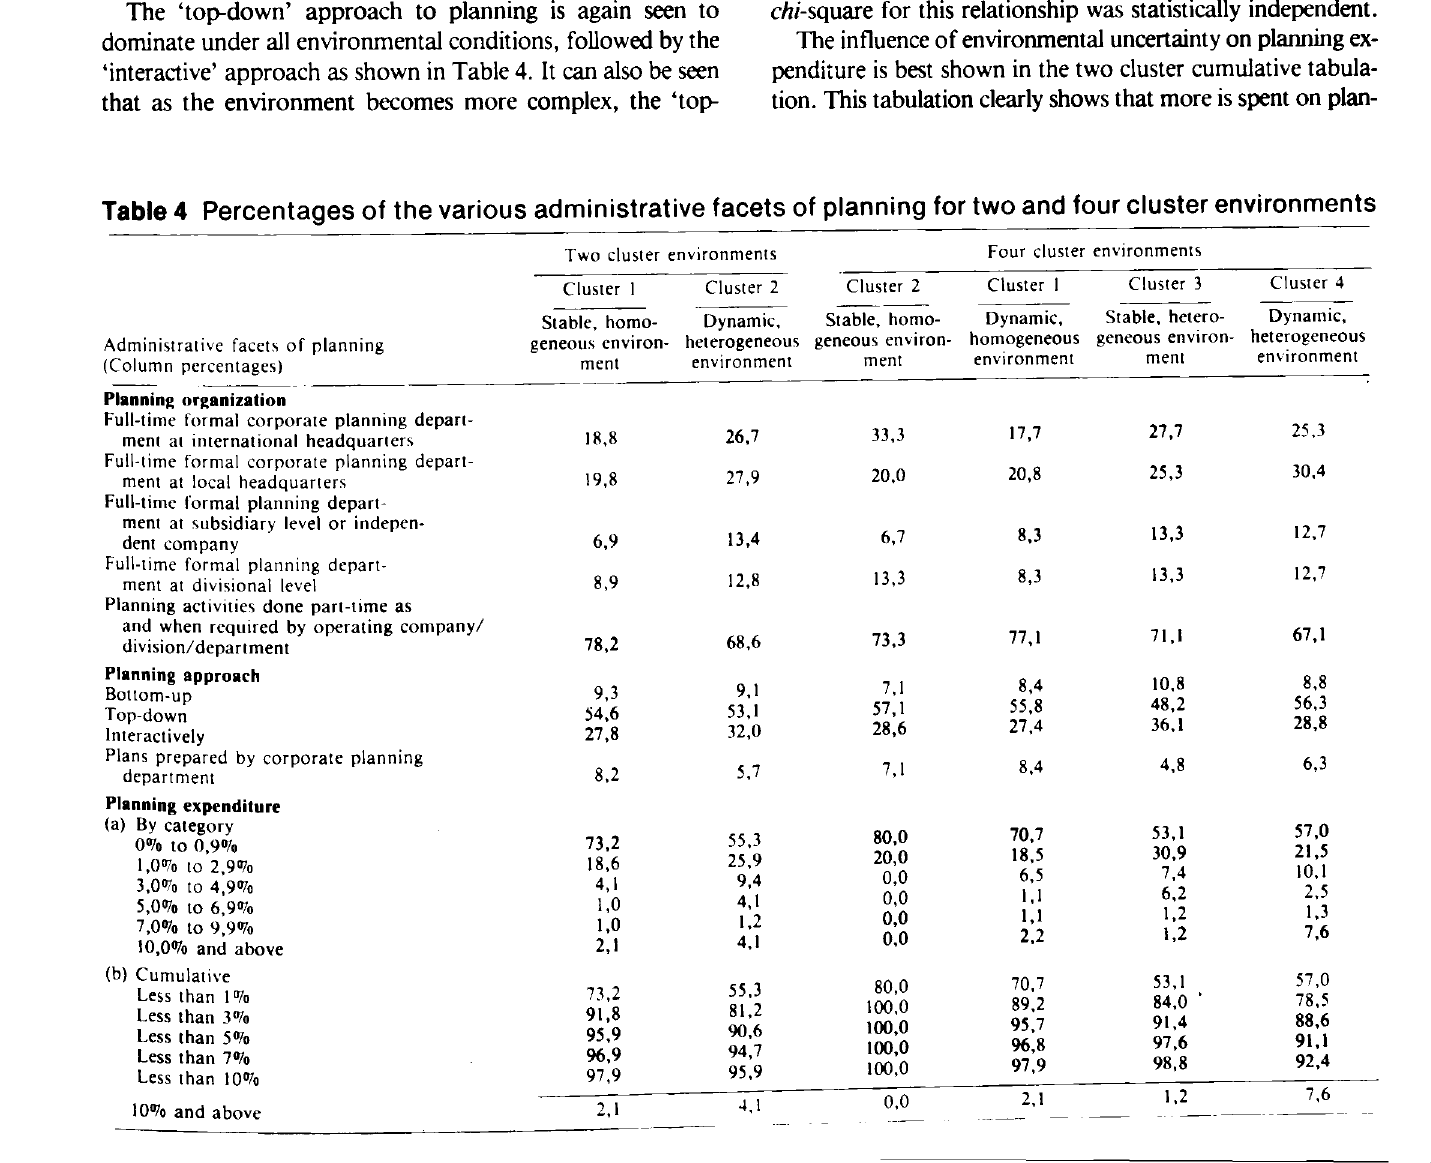
Table4 Percentages of the various administrative facets of planning for two and four cluster